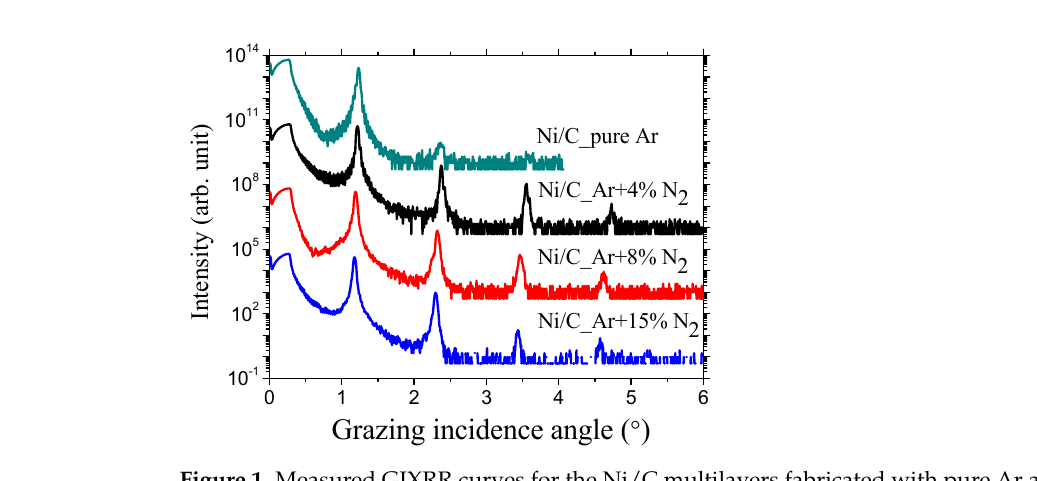
Figure 2. Cross-sectional HRTEM images and SAED patterns (insets) of Ni/C multilayers deposited with ( a ) pure Ar and ( b ) a mixture Ar + 4% N 2 as the working gas.